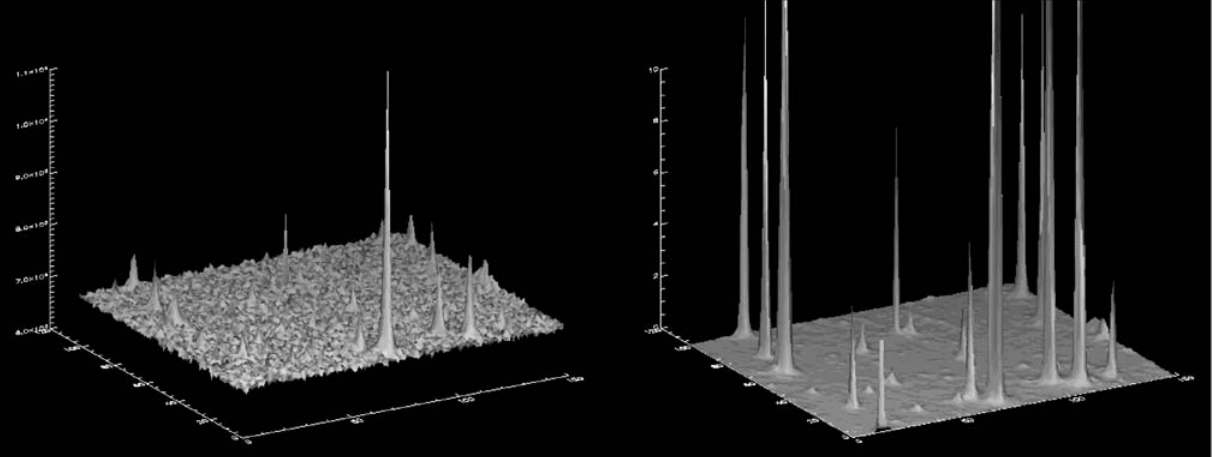
Figure 1. Plot showing a detail of a raw (left) and 140 AWMLE iterations deconvolved (right) image obtained with a retrofitted Baker-Nunn camera equipped with a CCD camera as image sensor. In order to ease the SNR comparison, the vertical axes were set to different ranges. In the case of the deconvolved image, up to six stars are out of range. The deconvolved image shows much larger SNR with respect to the raw image.